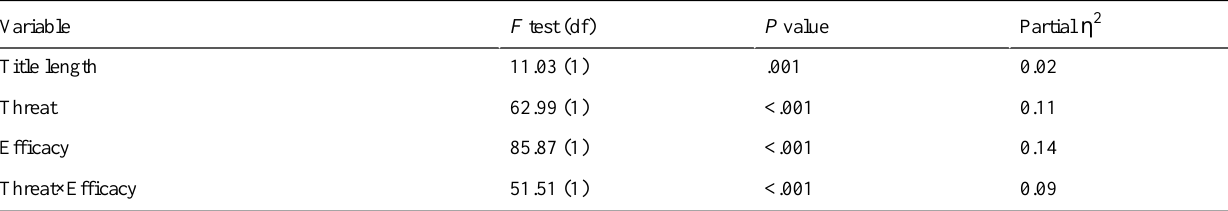
Table 2. Threat×efficacy factorial analysis of variance for the amount of